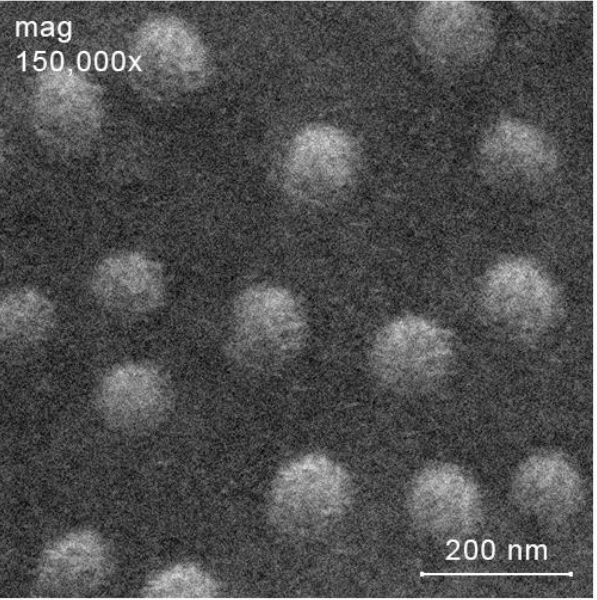
Figure 6. SEM image of the loaded nanoparticles prepared by ionic gelation method.